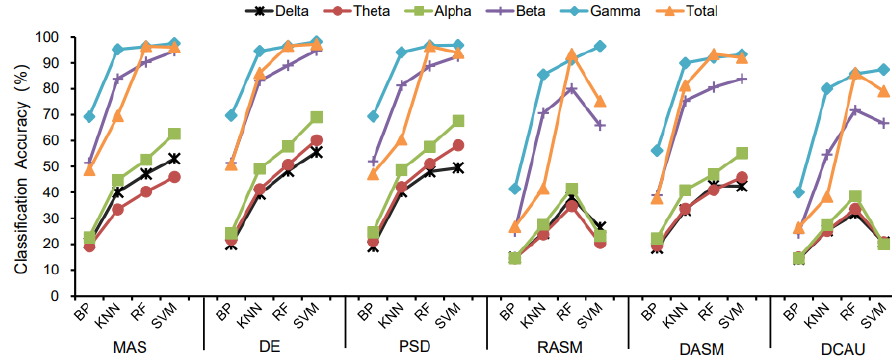
Figure 4. The classification results of different classifiers.